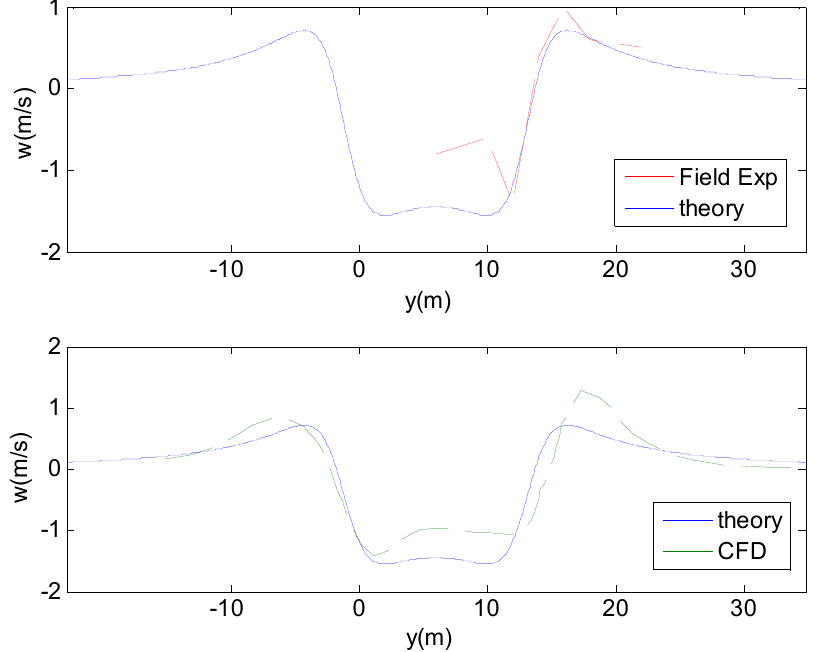
Figure 6. Comparison of vertical velocity at the height z = 3 m on yz plane at x = 0, “CFD” and “Field Exp” are results of computational fluid dynamics (CFD) and field measurement in [14], “theory”